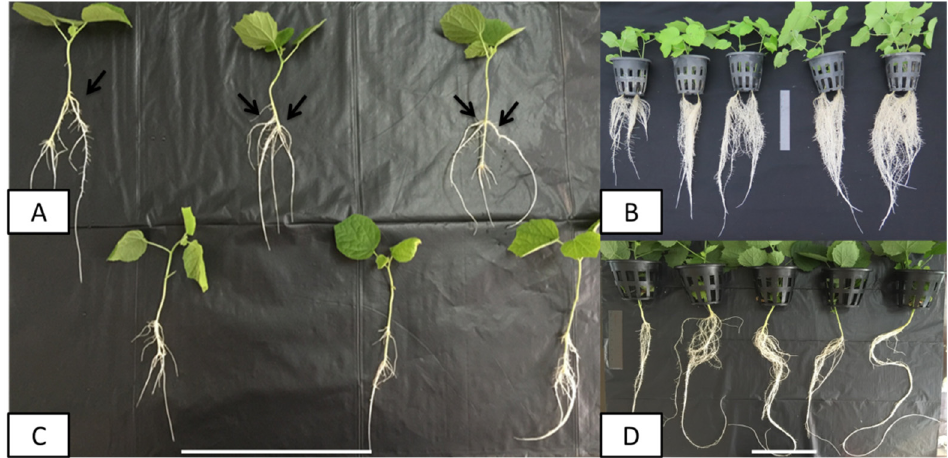
Figure 1. AHR induction after 7 days. ( A , C ) Transformed and non-transformed roots after 7 days; ( B , D ) transformed and non-transformed roots after 30 days. The black arrows indicate HR formation. Scale bar = 20 cm. Table 1. E ff ects of the infection time, type of medium, and ratio of mineral salt strength on the e ffi cient transformation and growth of Urena lobata aeroponic hairy roots (AHRs) after 30 days of